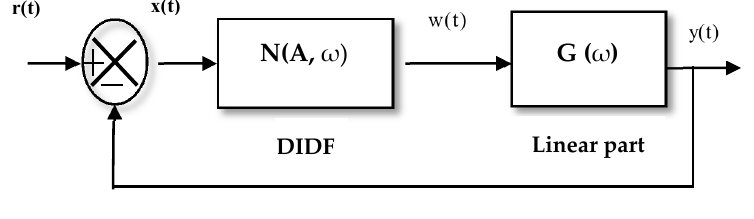
Figure 2. Nonlinear system. Figure 2. Nonlinear